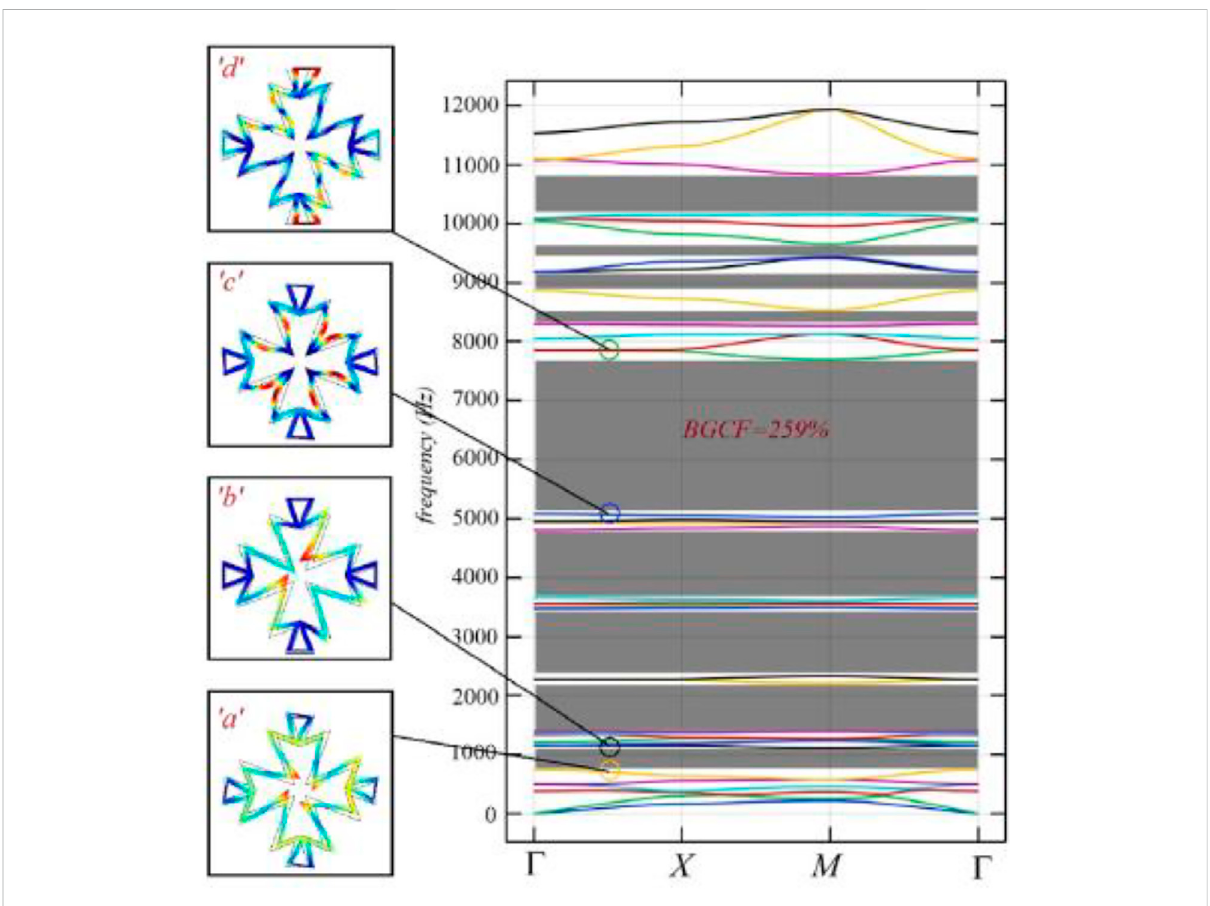
Figure 6. HFAM can enable applications ranging from acoustic